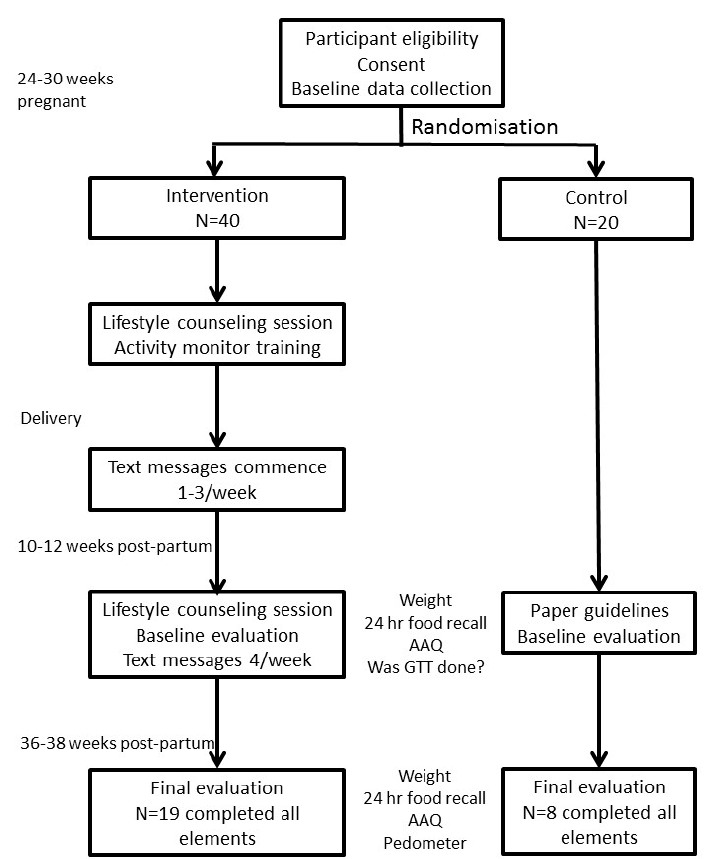
Figure 1. Study protocol and consort